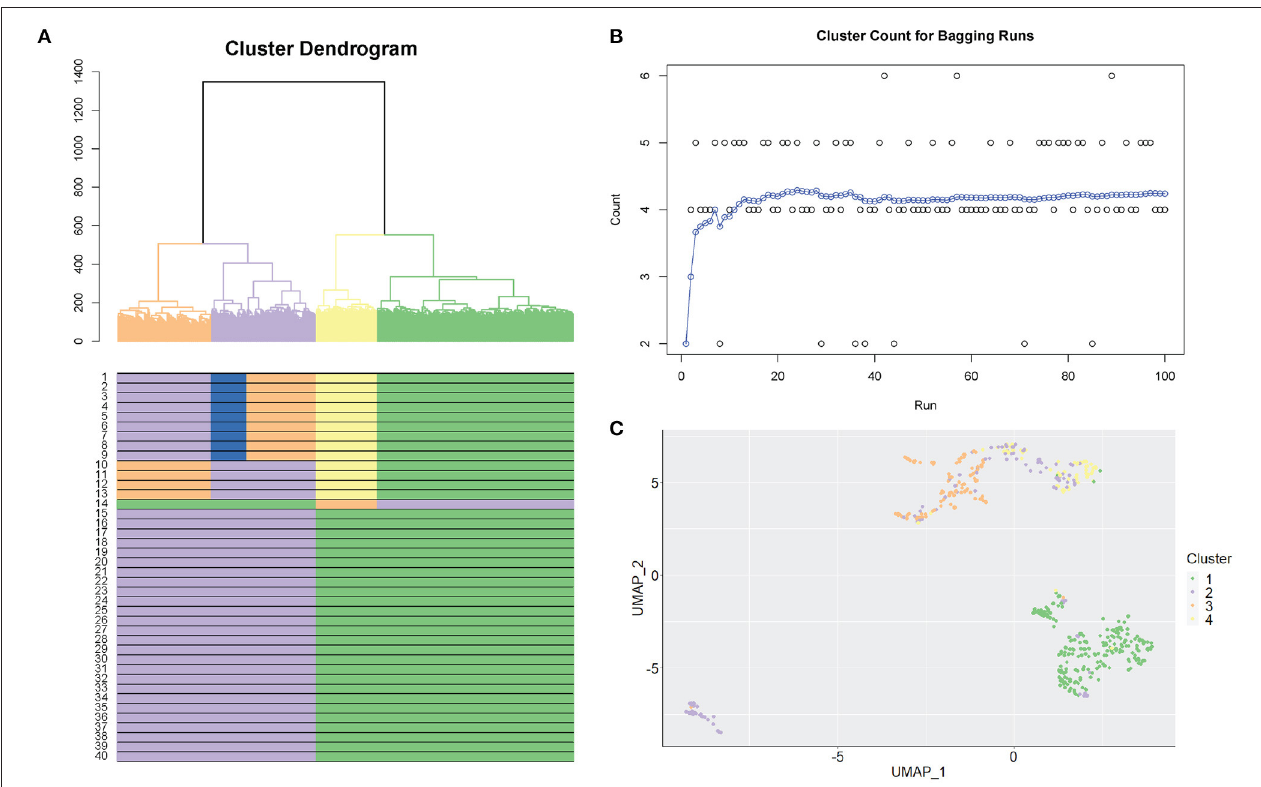
FIGURE 2 | Selection of stable clustering results. (A) SCORE cluster dendrogram. Coloured branches and bars (underneath the dendrogram) represent clusters. A coloured row displays the result from one clustering resolution (40 resolutions are shown). (B) Bagging cluster estimations. Each dot is one bootstrap result. The X-axis shows the order of the bootstraps from 1 to 100. The y-axis shows the number of clusters. Blue dots are the cumulative running average between consecutive clusters (i.e., continuous bootstraps). (C) UMAP plot representing the final chosen clustering result. Each colour represents one